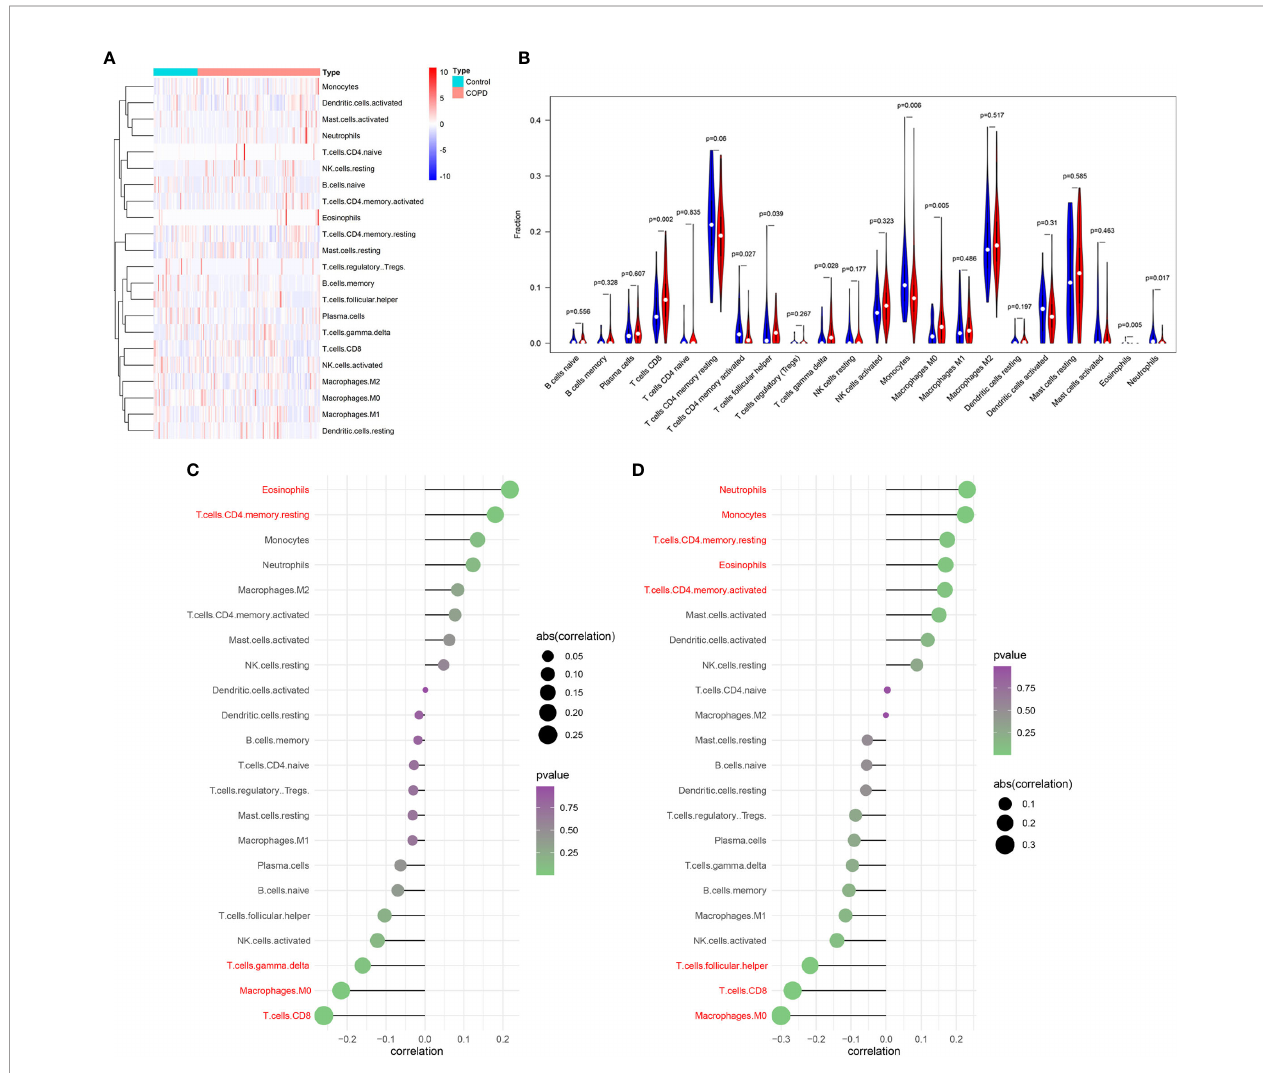
FIGURE 2 | Analysis of immune landscape associated with COPD. Heatmap (A) and violin plot (B) showing the distribution of 22 types of immune cells in normal smoker and COPD patients in GSE76925; (C) The relationship between FVC% predicted and immune cell in fi ltration level; red: statistically signi fi cant (P < 0.05); (D) The relationship between FEV1/FVC and immune cell in fi ltration level; red: statistically signi fi cant (P <